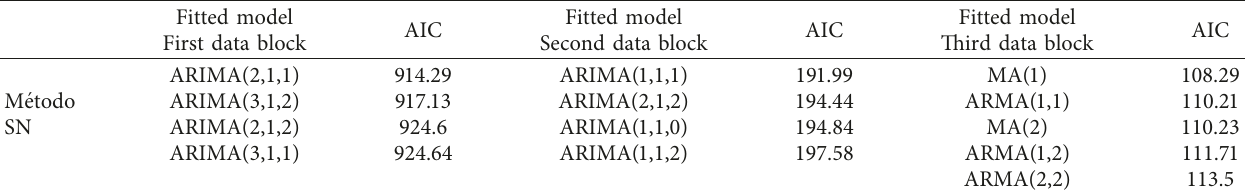
Table 10: Models fitted after applying the SN